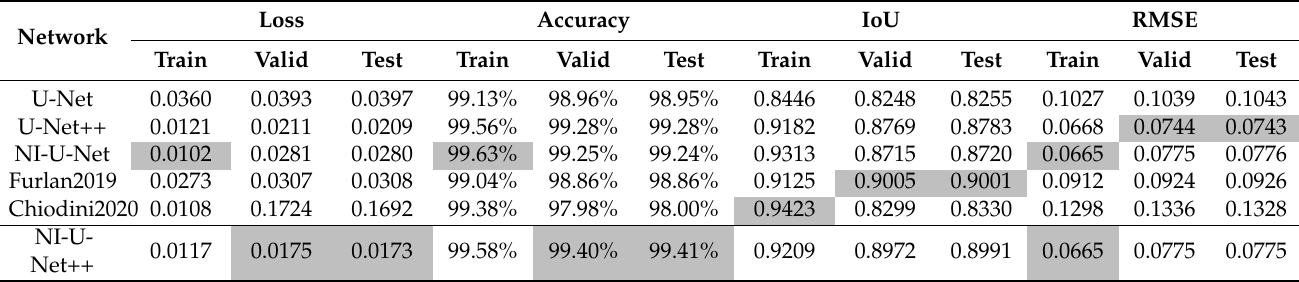
Table 5. The results of the pre-training process.